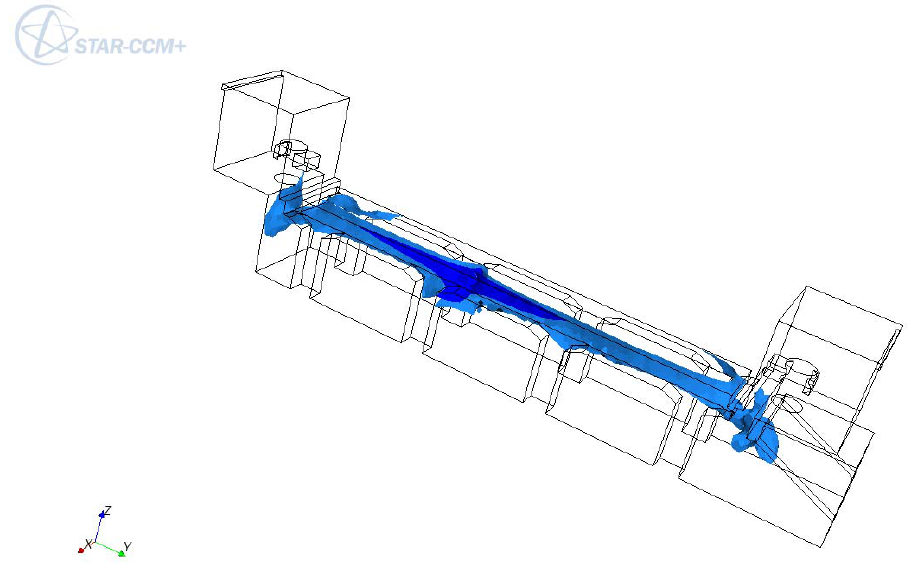
Figure 6. CFD model: LFL and 0.5 LFL concentration iso-surfaces at 600 s from the beginning of the release in coke battery A.